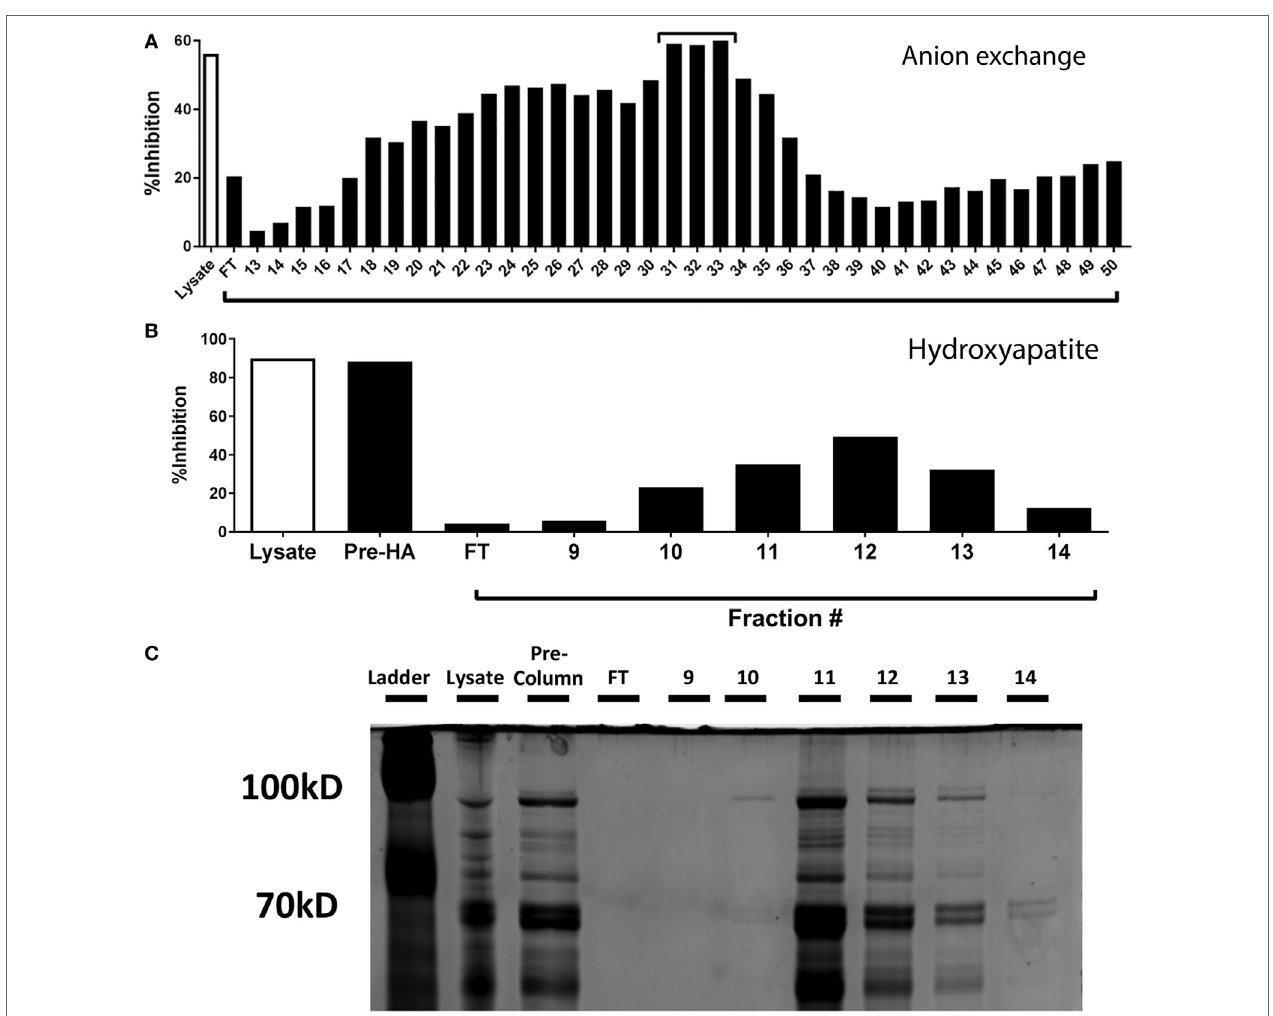
FigUre 4 | Purification and identification of the inhibitory protein from Streptococcus pneumoniae ( Spn ) lysates. (a) Proteins from EF3030-derived lysate were purified by anion exchange chromatography and protein containing fractions tested for their ability to inhibit IFN γ production. Total lysate served as a control. The fractions with the maximal inhibitory capability [denoted with a bar in (a) ] were pooled and passed over a hydroxyapatite column. The ability of the collected fractions to inhibit IFN γ production by NP-specific CTL is shown in (b) . In addition to total lysate, the pooled fractions from the anion exchange column are shown (Pre-HA). Samples from B were run on a denaturing polyacrylamide gel and stained with Coomassie Blue protein stain (c) . The protein band with an intensity that correlated with the inhibitory activity is identified by an arrow.